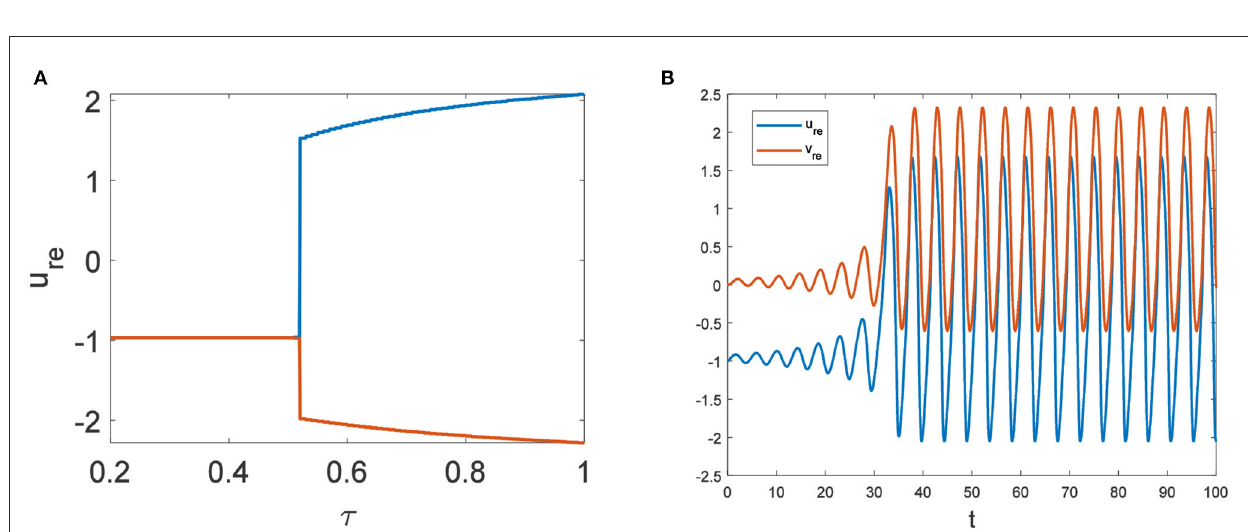
0.5227. (B) The time series diagram with τ =